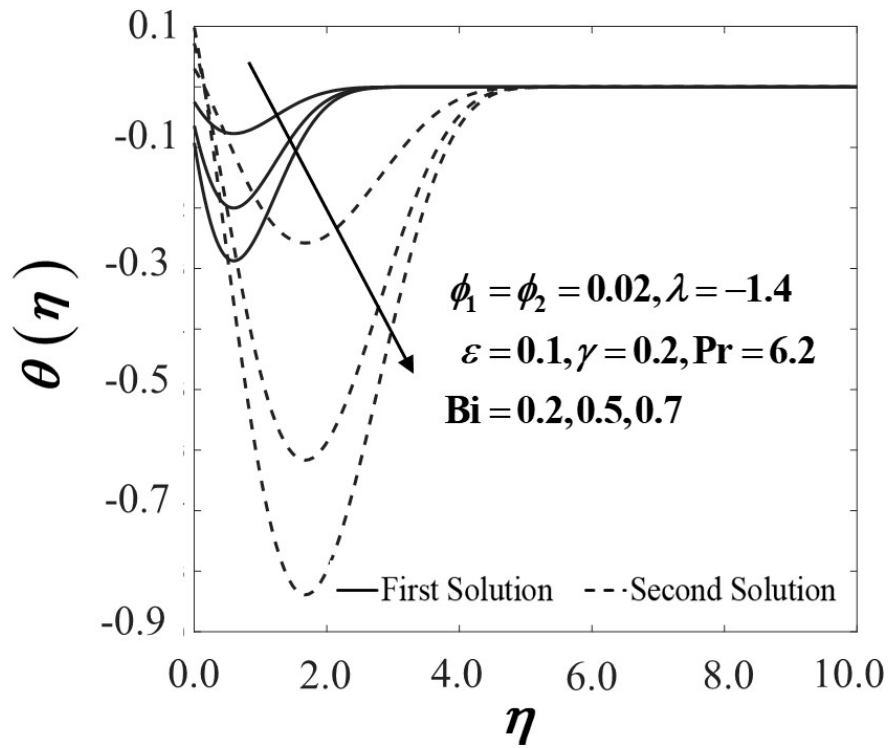
( ) θη with Bi 0.2,0.5,0.7. = Figure 15. Temperature profiles of θ ( η ) with Bi =